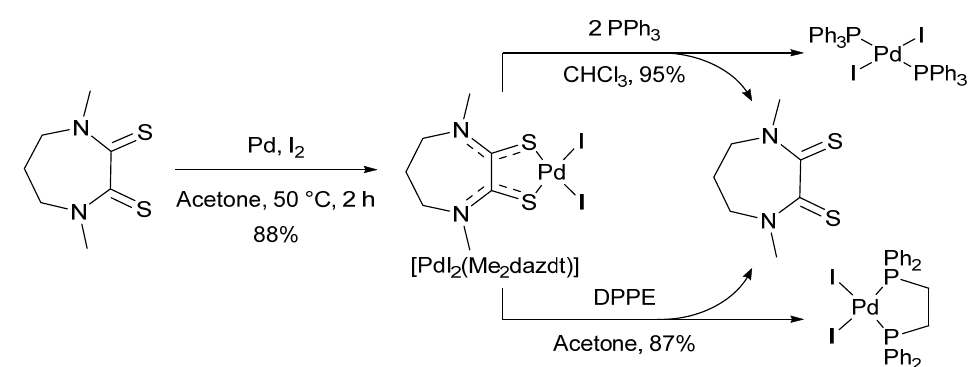
Figure 13. Expanded recovery products derived from Me 2 dazdt ∙ I 2 , Reproduced with permission from [107].